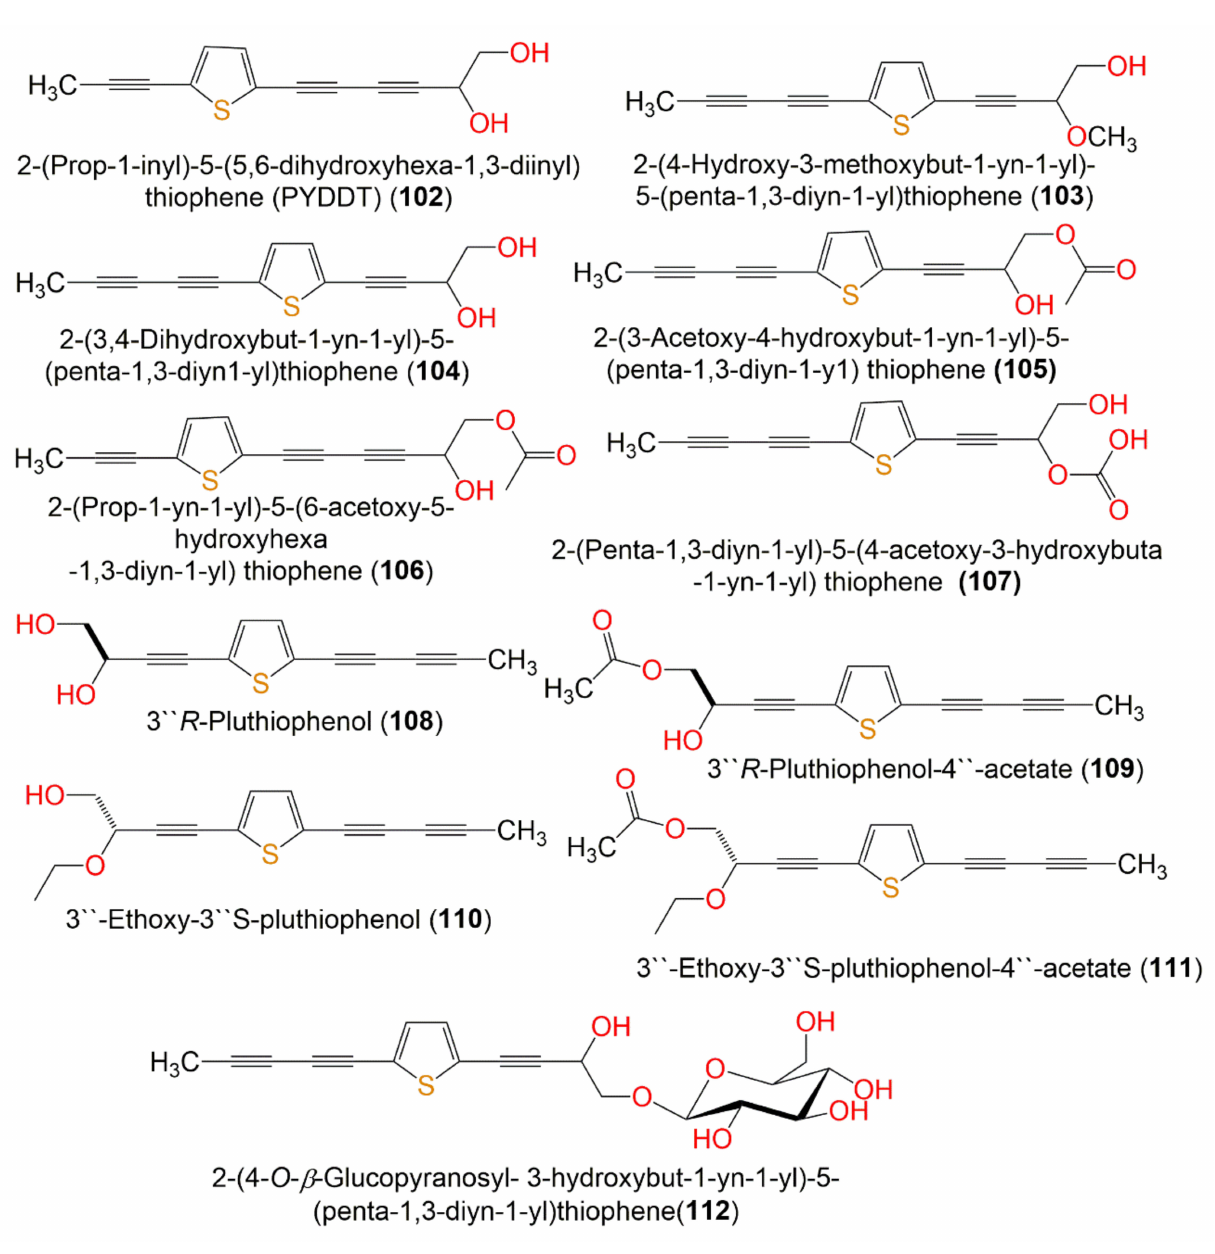
Figure 12. Structures of compounds 102 – 112